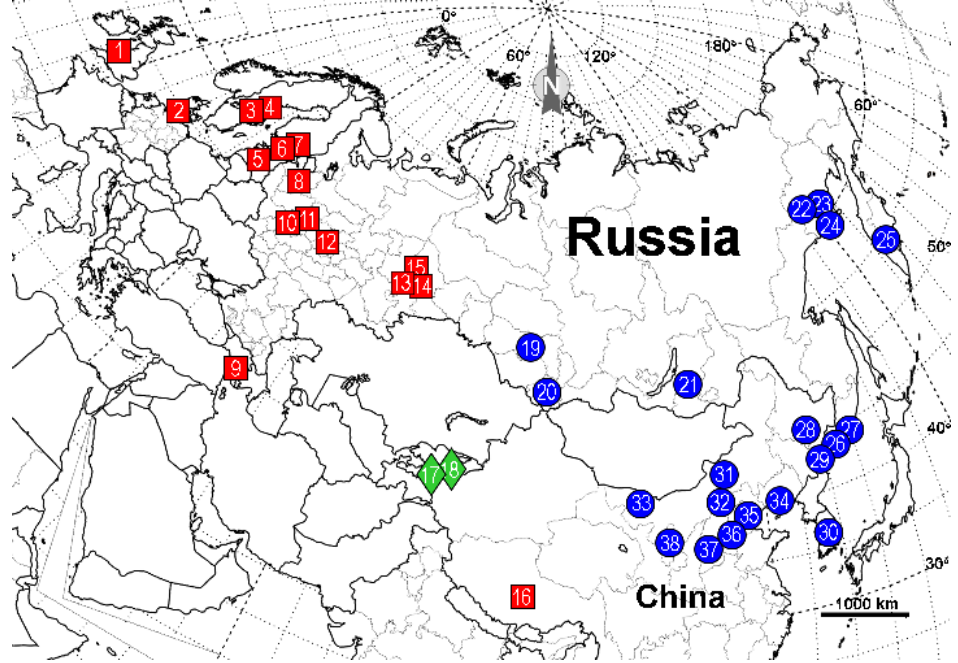
Figure 1. Specimens of the « F. picea — F. candida » complex used in this study. Red squares, F. picea ; green diamonds, F. candida ; blue circles, Formica sp. Specimen numbers refer to Table 1.